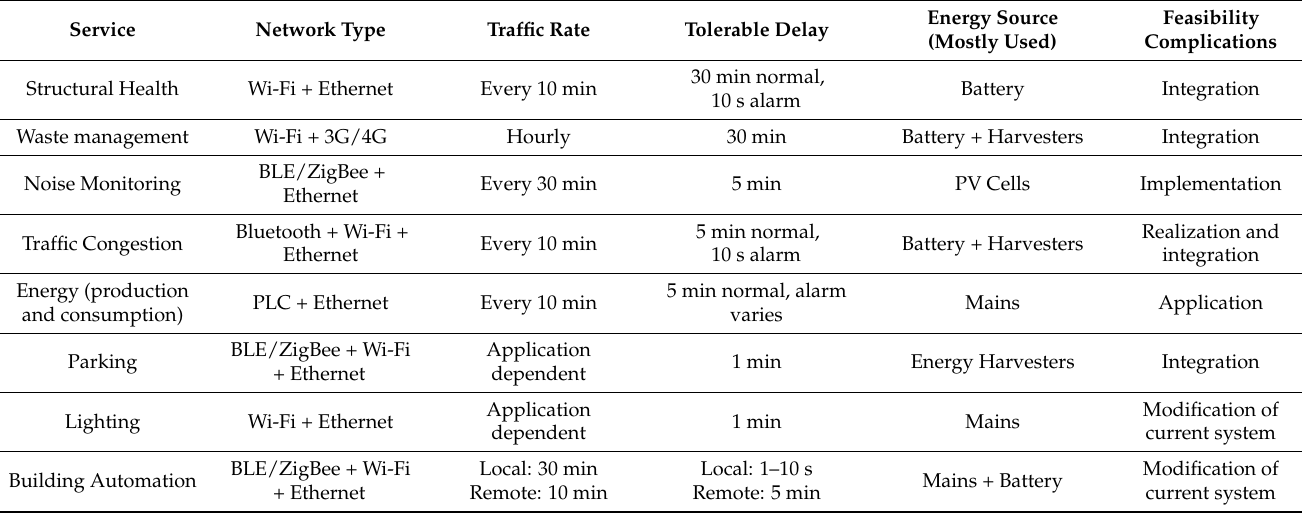
Table 4. Smart city services for Padova city and its network type, constraints, and feasibility overview.